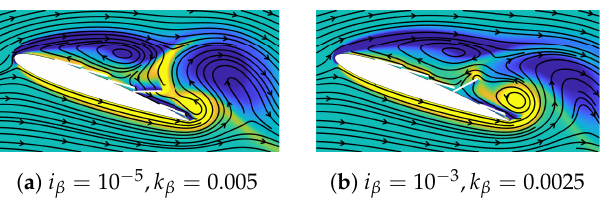
Figure 11. Vorticity contours at t / T = 0.45 demonstrating the downward moving flap 4 countering the TEV and its reverse flow.